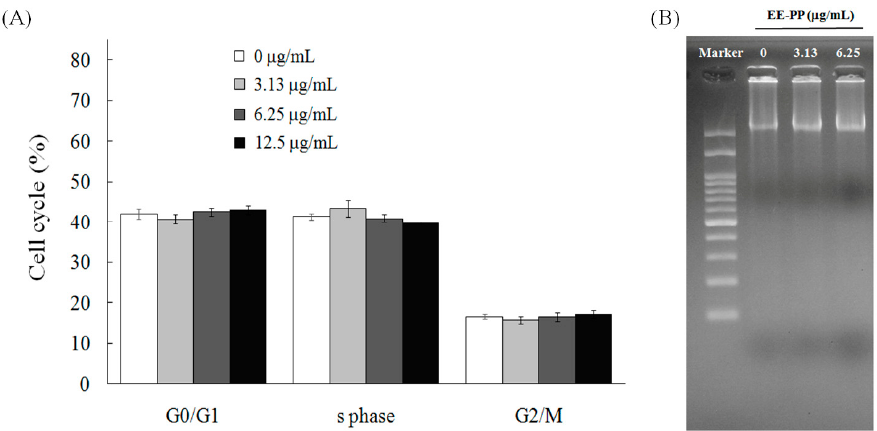
Figure 2. No effects of EEPP on ( A ) cell-cycle distribution and ( B ) DNA ladder in DLD-1 colorectal carcinoma cells. Data are shown as means ± SD ( n = 3).